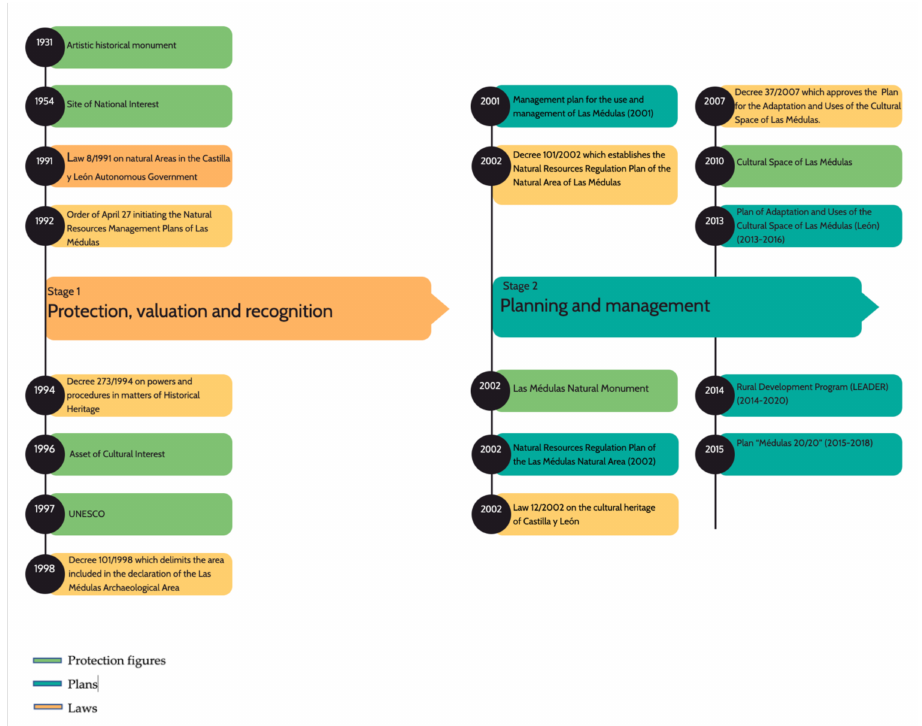
Figure5. Designationofthemainfiguresofprotection, assessmentandplanning. Source: